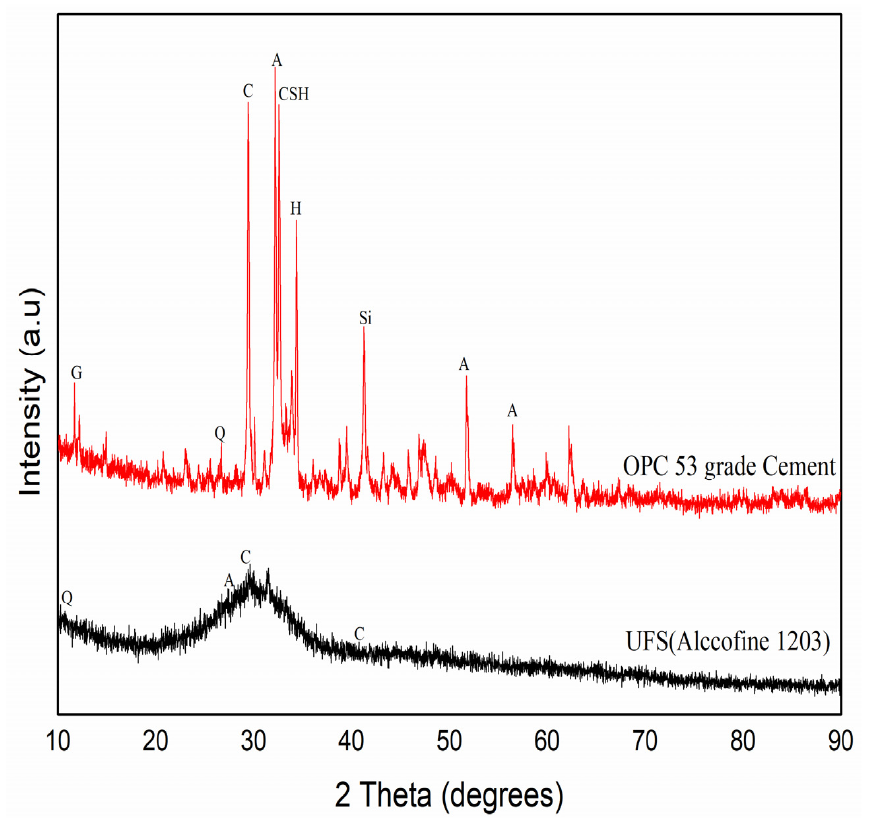
Figure 4. XRD of 53 grade OPC and UFS (Alccofine 1203).